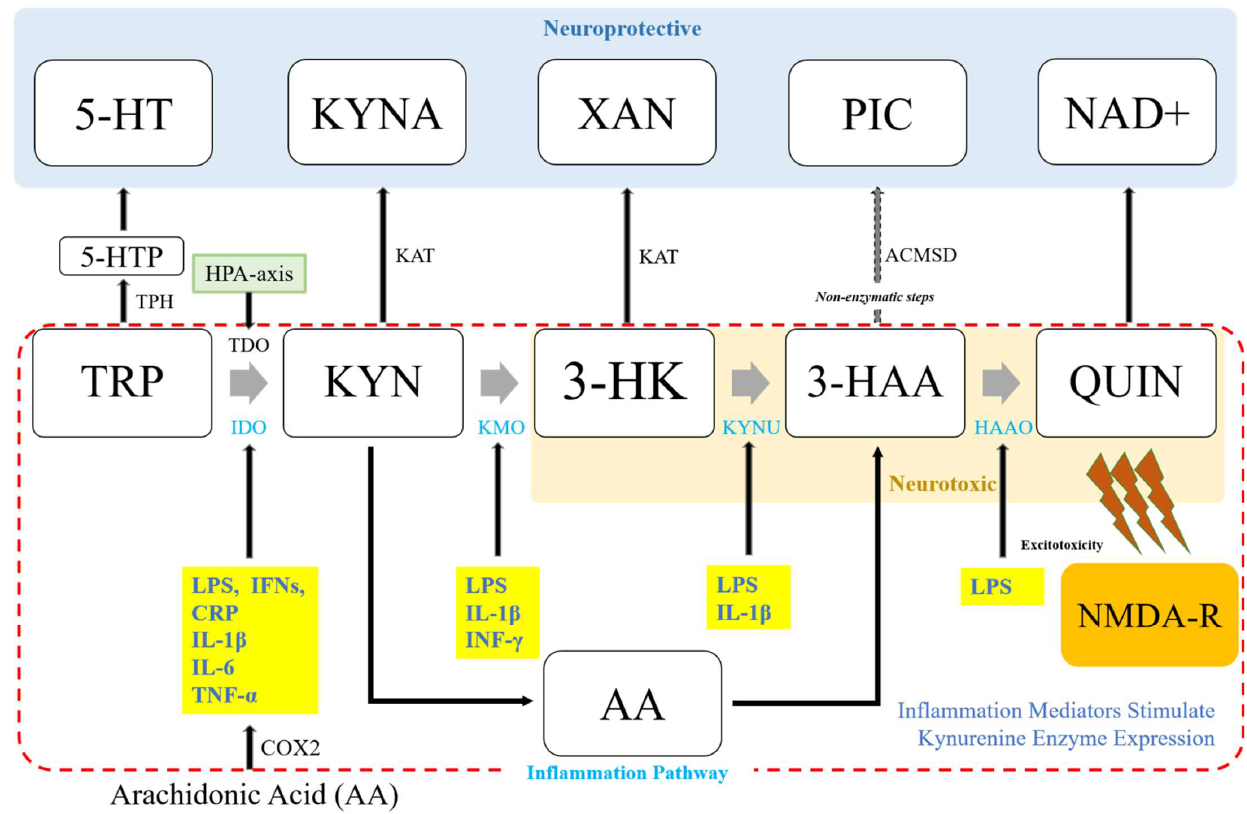
Figure 2. Schematic connection between the kynurenine pathway and nflammation. The kynurenine pathway (KP) bifurcates into two distinct branches modulated by the availability of l-kynurenine in the brain: KATs, and KMO. In addition, a variety of inflammation-related mediators known to affect enzyme expression can regulate the metabolism of kynurenine by adjusting substrate availability and metabolite formation, preferring the KMP direction of the pathway with immune-related pathological conditions. TRP, tryptophan or L-tryptophan; TDO, TRP 2,3-dioxygenase; 5-HT, serotonin; KYN, kynurenine or l-kynurenine; 5-HTP, 5-hydroxytryptophan; HPA-axis, hypothalamic-pituitary-adrenal axis; KYNA, kynurenine acid; 3-HK, 3-hydroxykynurenine; AA, anthranilic acid; XA, xanthurenic acid; NAD+, nicotinamide adenine dinucleotide; PIC, picolinic acid; 3-HAA, 3-hydroxyanthranilic acid; ACMSD, aminocarboxymuconate semialdehyde decarboxylase; QUIN, quinolinic acid; NMDA-R, N-methyl-D-aspartate receptor; IDO, indoleamine-2,3-dioxygenase; KAT, kynurenine aminotransferase; KMO, kynurenine 3-monooxygenase; KYNU, kynureninase; HAAO, 3-hydroxyanthranilic acid oxidase; LPS, lipopolysaccharide; BCG, bacillus Calmette-Guerin; IFNs, interferons; TNF, tumor necrosis factor; IL, interleukin; TNF-α; tumor necrosis factor alpha, IFN-γ, interferon gamma; COX2, cyclooxygenase 2.